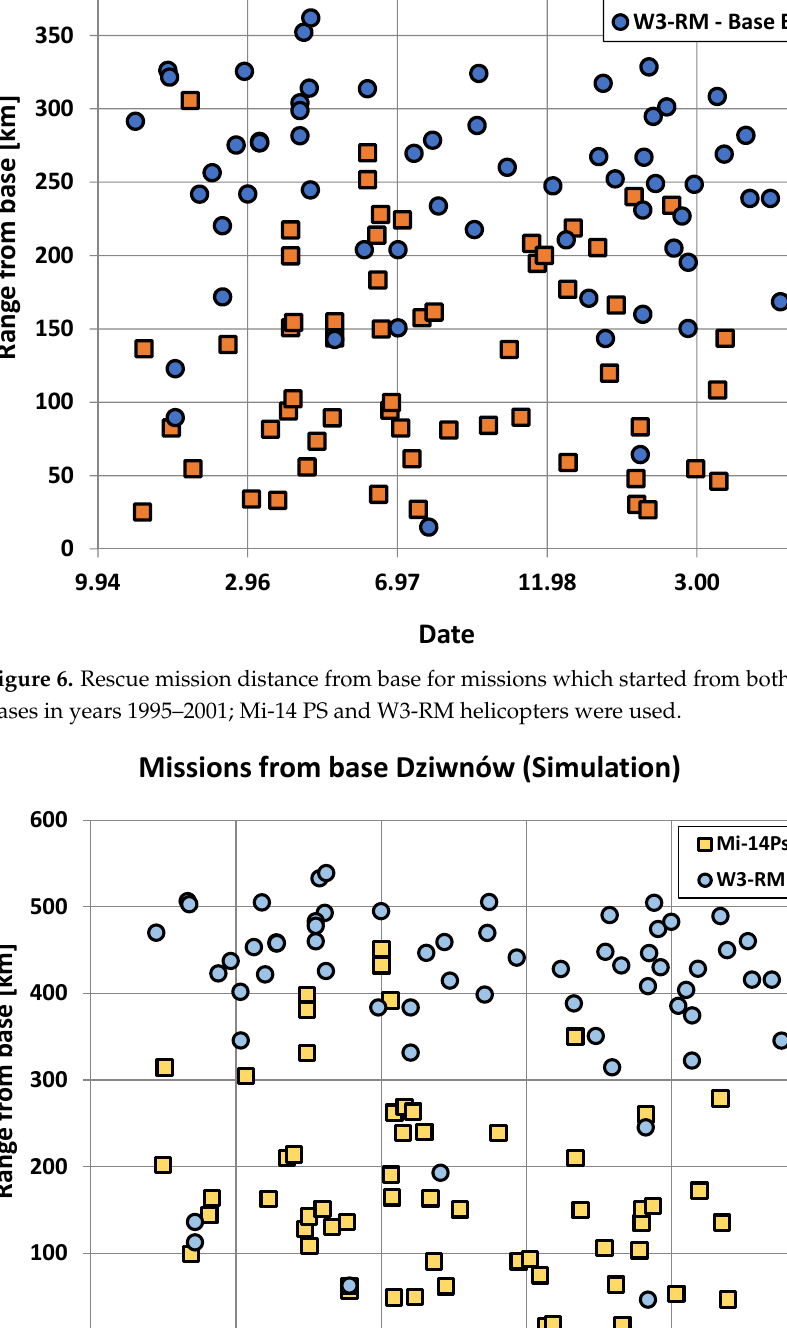
Figure 8. Range from base for simulated missions closer than 150 km which started from Dziwnów base in years 1995–2001; W3-RM and Mi-13PS helicopters were used. Figure 9 shows the percentage distribution of missions depending on the distance from the starting base. It was observed that 40% of the missions launched at the EPDA base were carried out at a point more than 150 km from the base. It can be concluded that